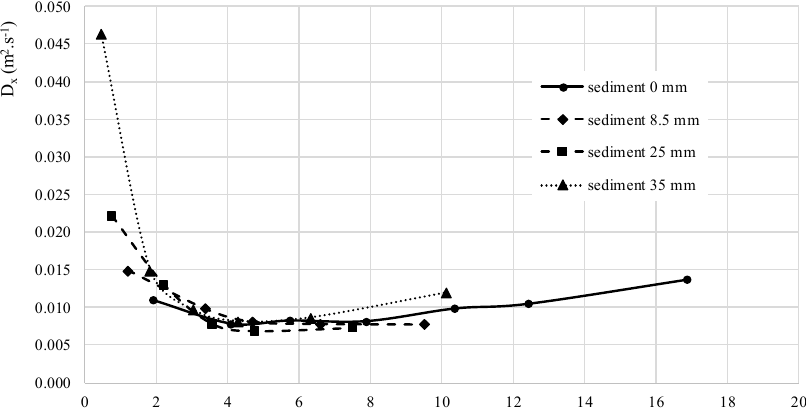
Figure 5. Relationship between D x and u c from tracer experiments results. D x is evaluated according to Gaussian approximation function (Equation (3)).